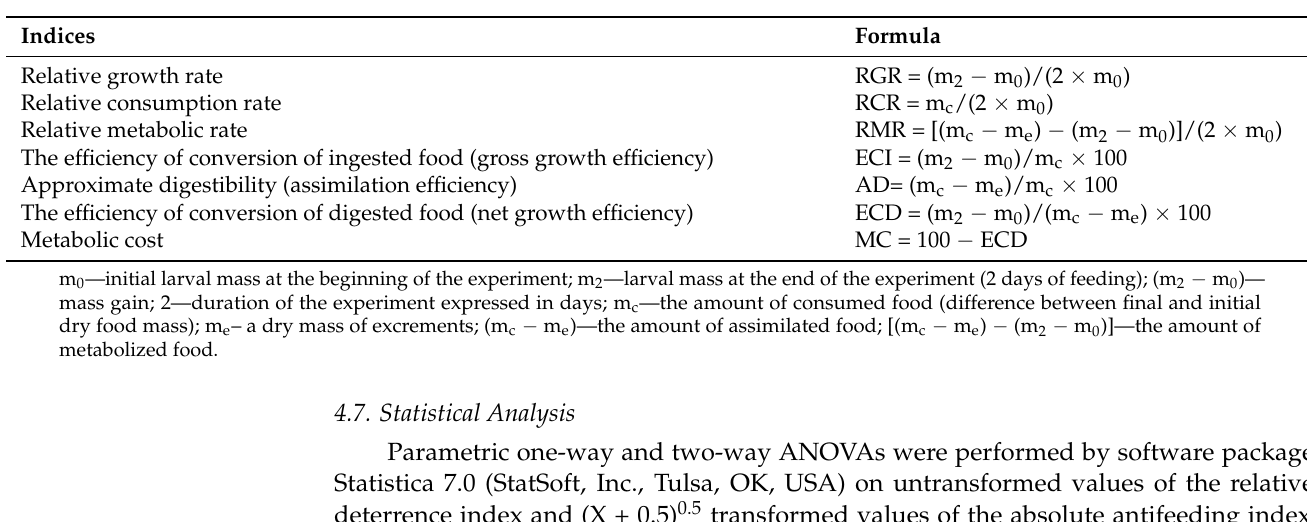
Table 2. Formulae for calculation of growth and nutritional